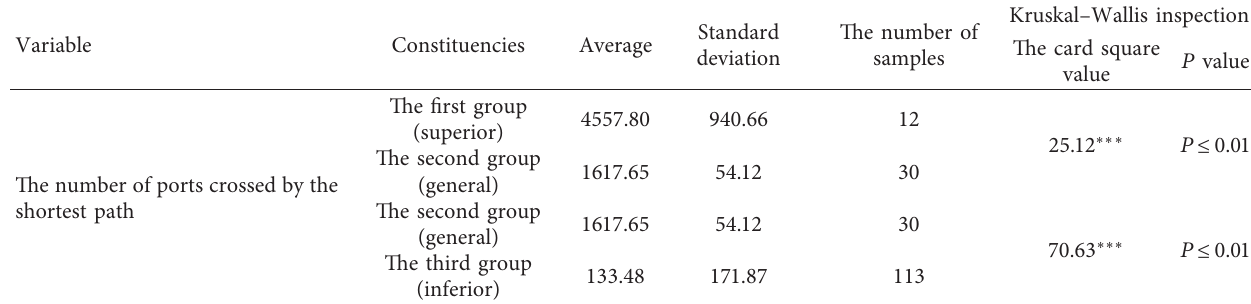
Table 7: Kruskal–Wallis test grouping